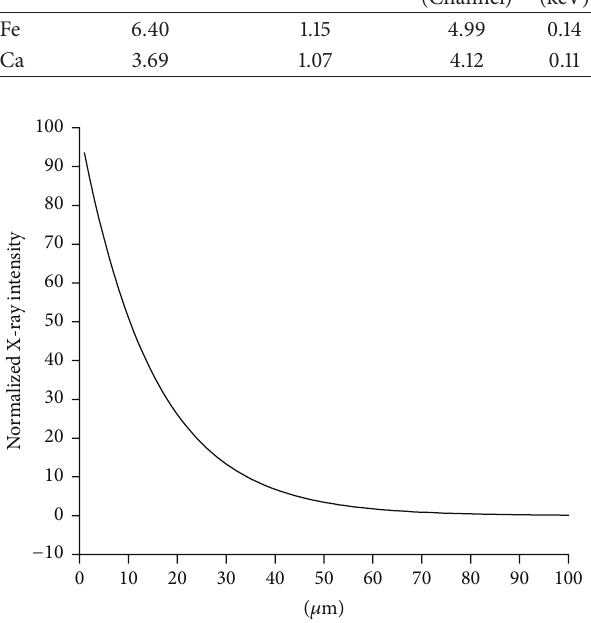
Figure 4: Theoretical attenuation according to (1) for the Ca-K 𝛼 (3.69 keV) through the vanadium